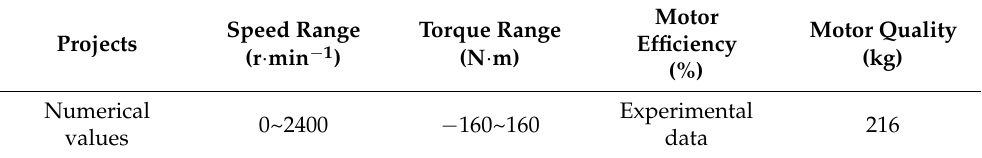
Table 4. Parameters of the permanent magnet motor.